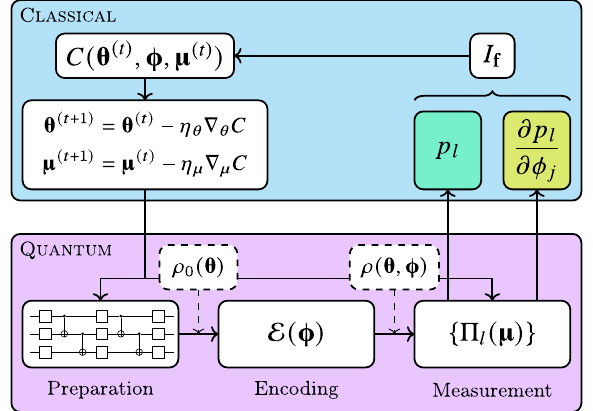
Fig. 1 Illustration of the Algorithm. Illustration of the hybrid approach presented in this work to variationally optimize the probe state and measurement for a noisy multi-parameter estimation problem. The various parameters are de fi ned in the main